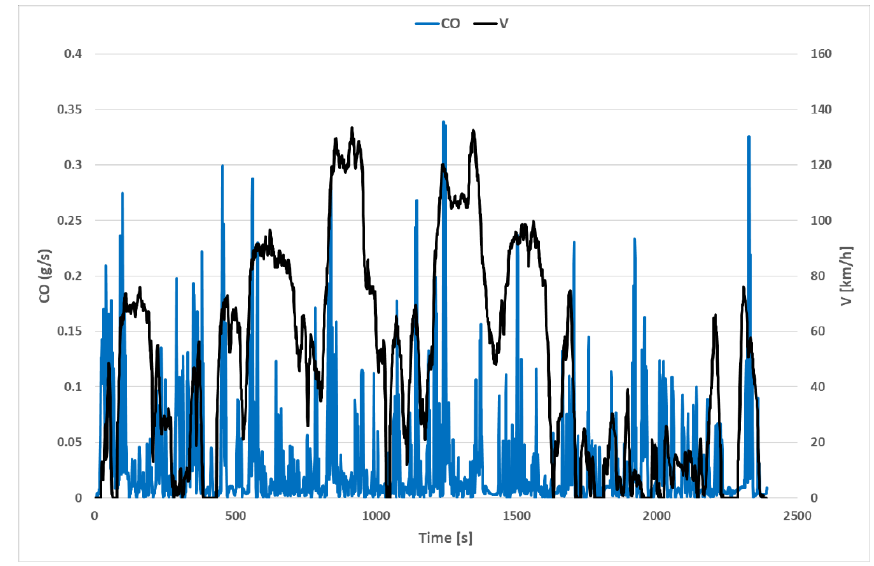
Figure 12. CO emission versus vehicle speed in on-road test, petrol propulsion.